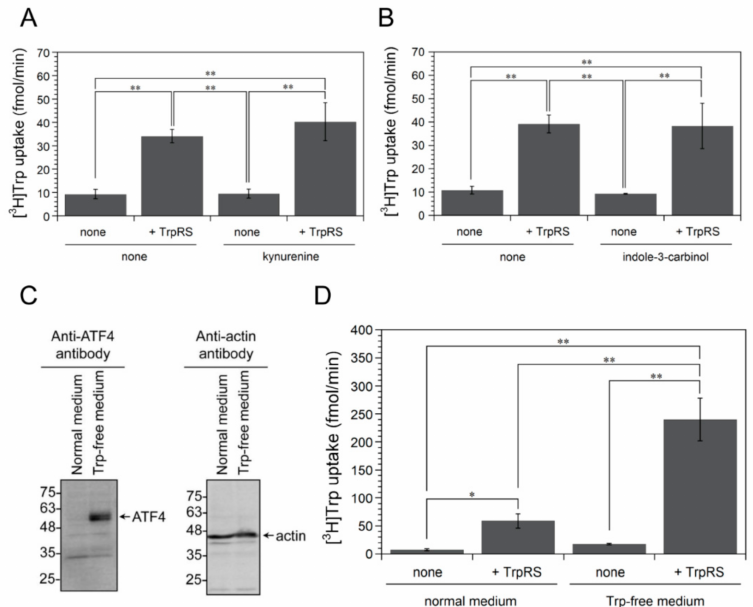
Figure 3. The e ff ect of the aryl hydrocarbon receptor (AhR) agonists or Trp depletion on TrpRS-mediated high-a ffi nity Trp uptake. ( A ) [ 3 H]Trp uptake into HeLa cells, which were treated without or with 1 mM kynurenine (Kyn) for 24 h, in the absence or presence of human TrpRS protein. All data are expressed as means ± SD of three independent experiments. ** p < 0.01. ( B ) [ 3 H]Trp uptake into HeLa cells, which were treated with 0.05% dimethyl sulfoxide (DMSO) as a control or 50 µ M indole-3-cabinol (I3C) dissolved in DMSO (final concentration 0.05%) for 24 h, in the absence or presence of human TrpRS protein. All data are expressed as means ± SD of three independent experiments. ** p < 0.01. ( C ) Western blot analysis of extracts from HeLa cells incubated in normal medium or in Trp-free medium. Western blot analysis of HeLa cell extracts using anti-ATF4 or anti- β -actin antibodies. The arrows indicate the expected positions of ATF4 and β -actin. Molecular size markers (kDa) are shown on the left. ( D ) [ 3 H]Trp uptake into HeLa cells, which were incubated in normal medium or in Trp-free medium, in the absence or presence of human TrpRS protein. All data are expressed as mean ± SD of four independent experiments. ** p < 0.01, * p <